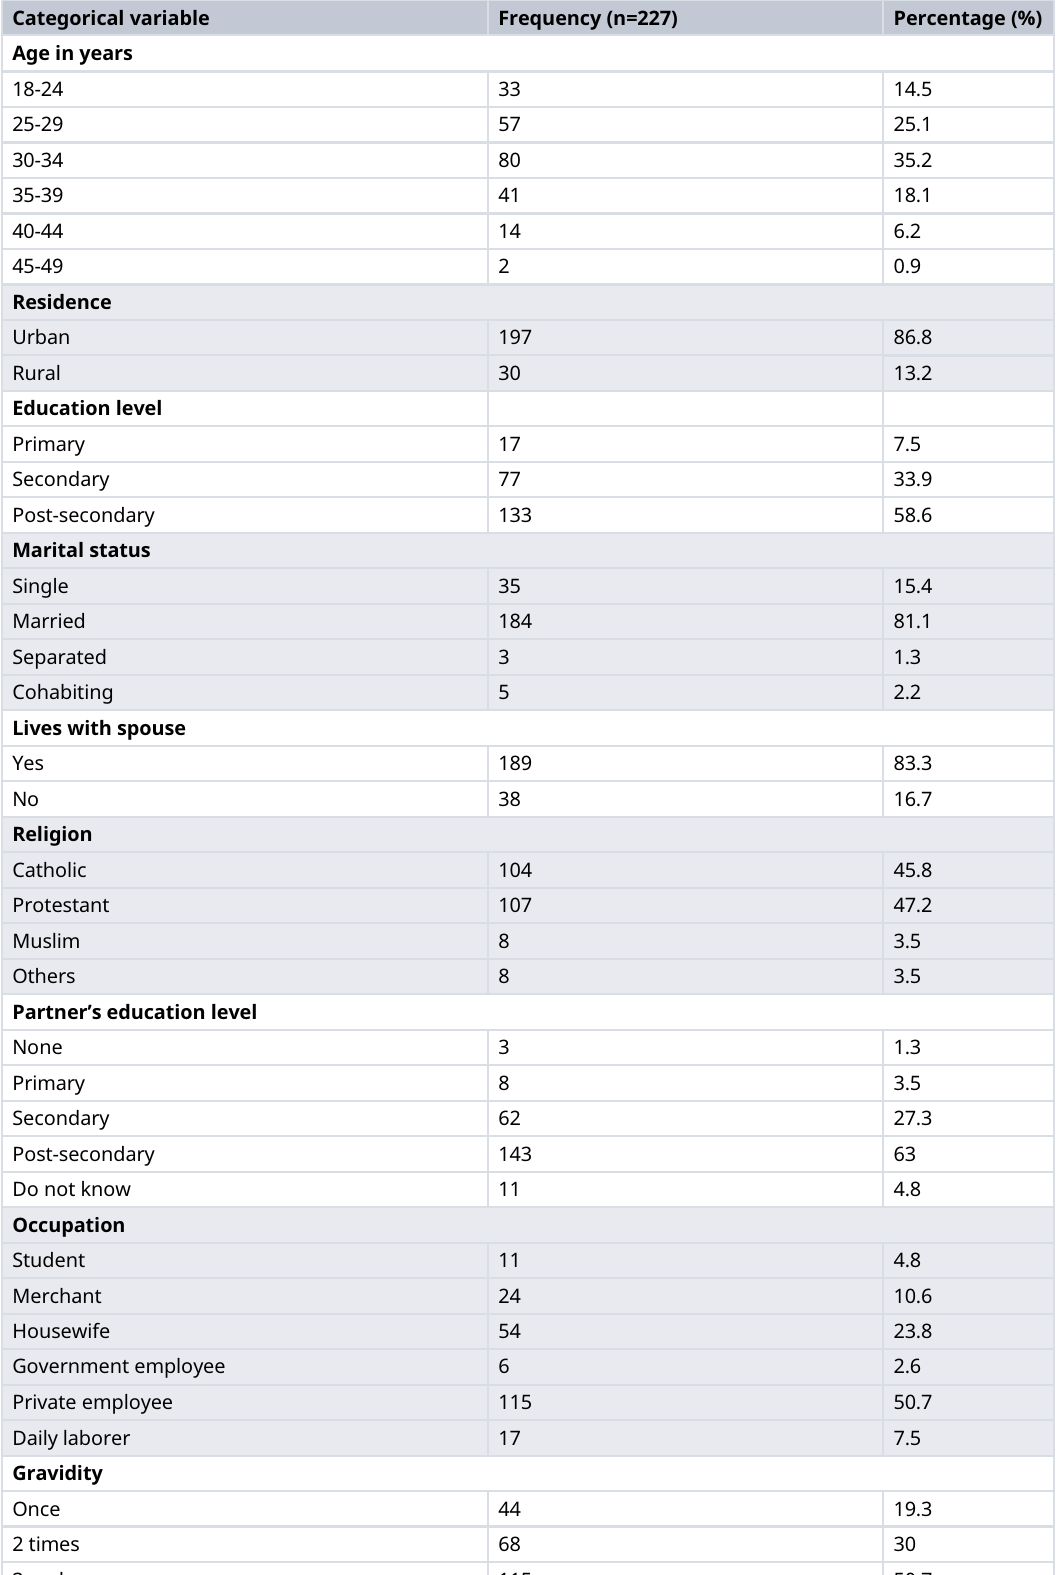
Table 1. Sociodemographic characteristics of the study